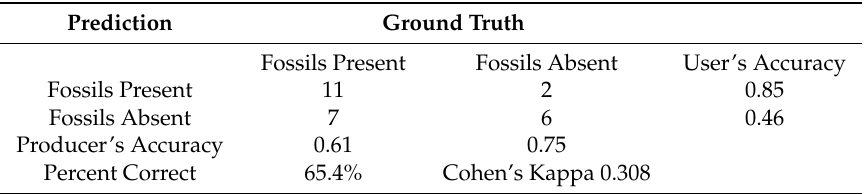
Table 3. Retrospective results of 2013 field season from the Landsat 8 OLI image.